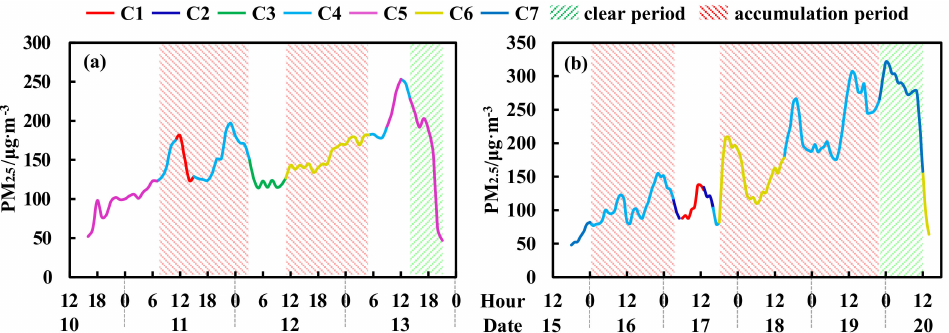
Figure 10. The dominant contributions of seven transport pathways during the haze episodes of ( a ) period 1 and ( b ) period